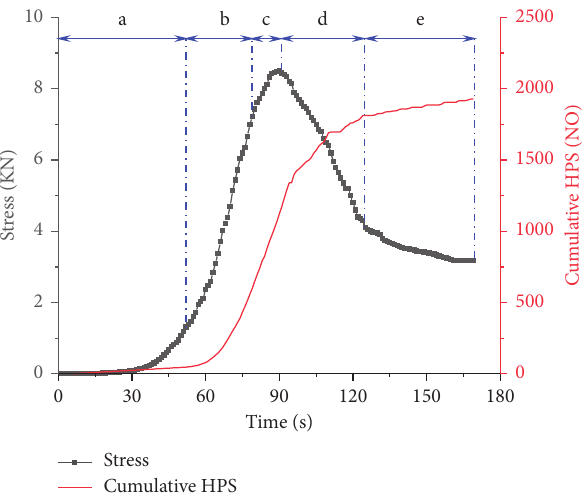
Figure 6: The stress-time curve and AE cumulative HPS-time curve of backfill under uniaxial